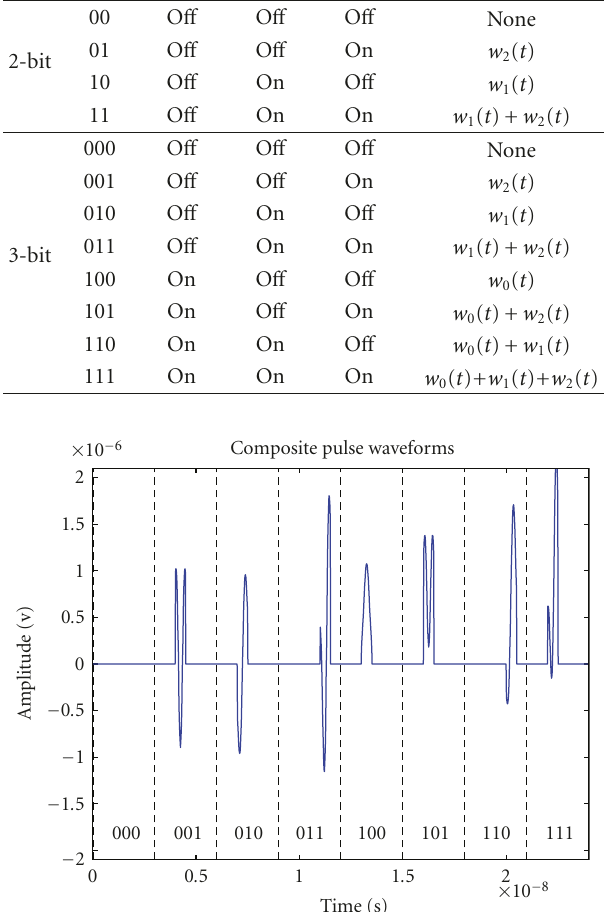
Table 1: Transmitted pulses for 2-bit and 3-bit symbols. Schemes